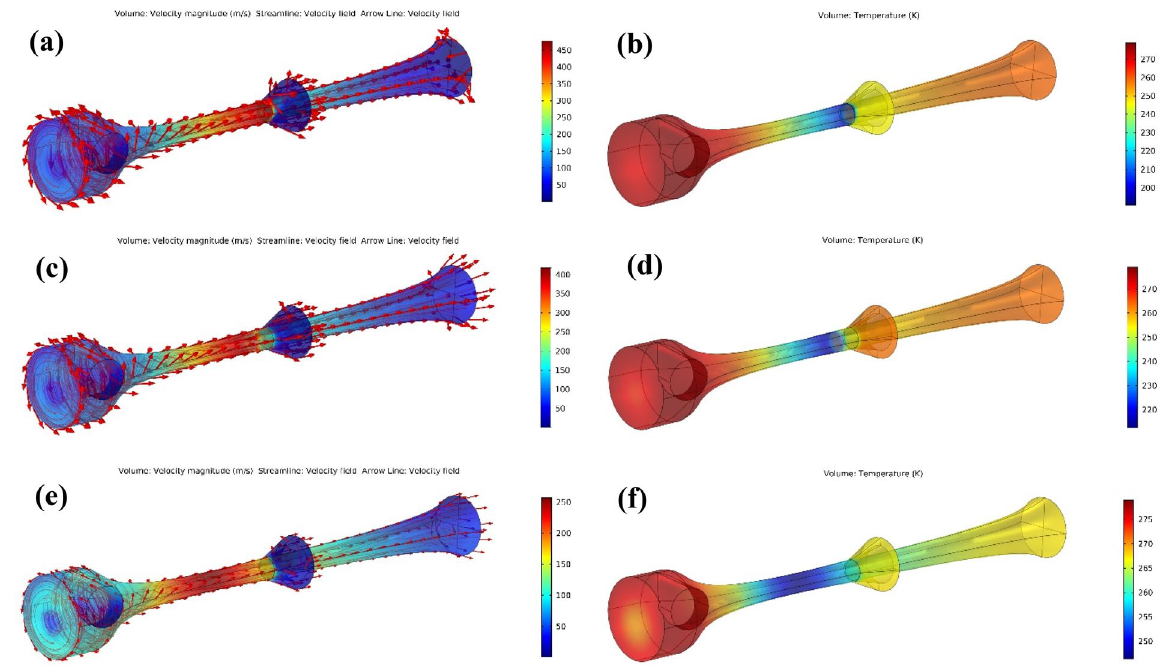
Figure 14. The influence of PLR on the velocity ( a , c , e ) and temperature profile ( b , d , f ) for ( a , b ) PLR = 0.3, ( c , d ) PLR = 0.225 and ( e , f ) PLR =